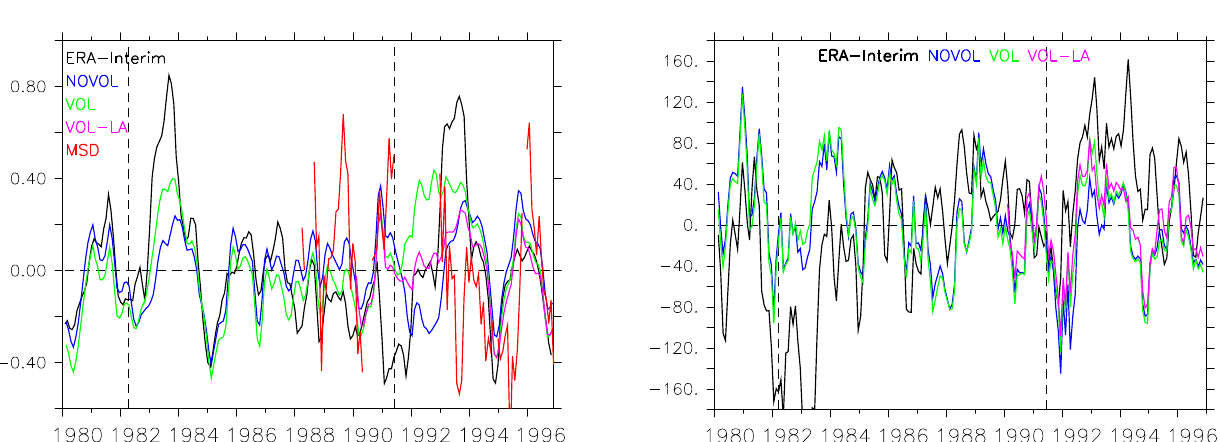
Figure 4. Anomaly of the monthly averaged tropical (20 ◦ S–20 ◦ N) upwelling (10 − 6 Pas − 1 ) at 100hPa calculated from ERA-Interim (black) and as simulated in the NOVOL (blue) and VOL (green) simulations. The purple line (VOL-LA) shows the result of a sen- sitivity simulation (Mount Pinatubo period, only), for which the stratospheric aerosol extinction was scaled by a factor of 0.5. The anomalies have been calculated based on the period 1980–1996 for ERA-Interim, NOVOL and VOL, and 1990–1996 for VOL-LA, re- spectively, and further smoothed with a box-smoother of 3 months length. The upwelling ( w ∗ ) has been calculated according to the TEM (Transformed Eulerian Mean) method as described by Holton (2004). The vertically oriented dashed lines indicate the eruptions of El Chichón (March 1982) and Mount Pinatubo (June 1991), re-